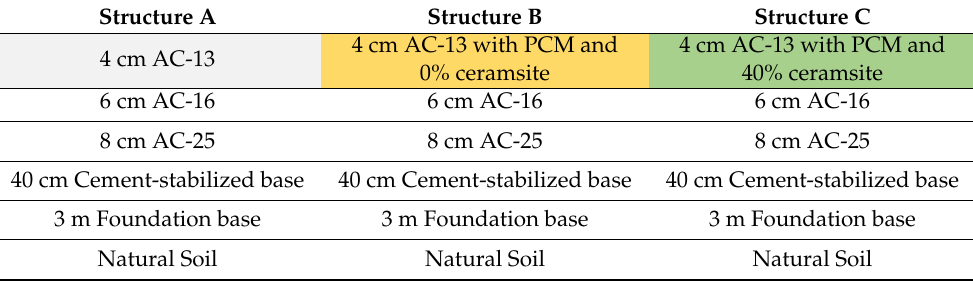
Table 3. Schematic diagram of the road